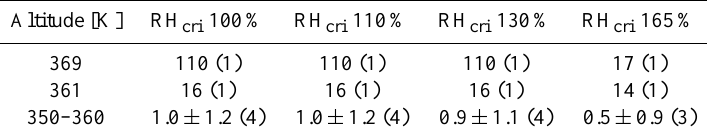
Table 2. Dehydration rate measured by the relaxation time τ [hour] as a function of the critical value of RH ice that enables ice nucleation RH cri , derived from matches. The values of mean τ and the standard deviation are indicated in the altitude region from 350K to 360K. The numbers of matches are shown in